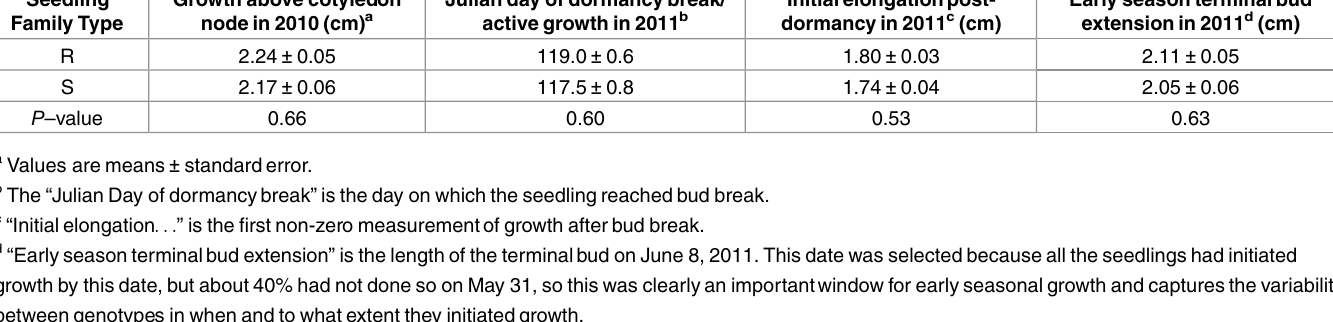
Table 2. Development, phenologyand early growth of R and S seedlingfamiliesof limberpine. Seedling Family